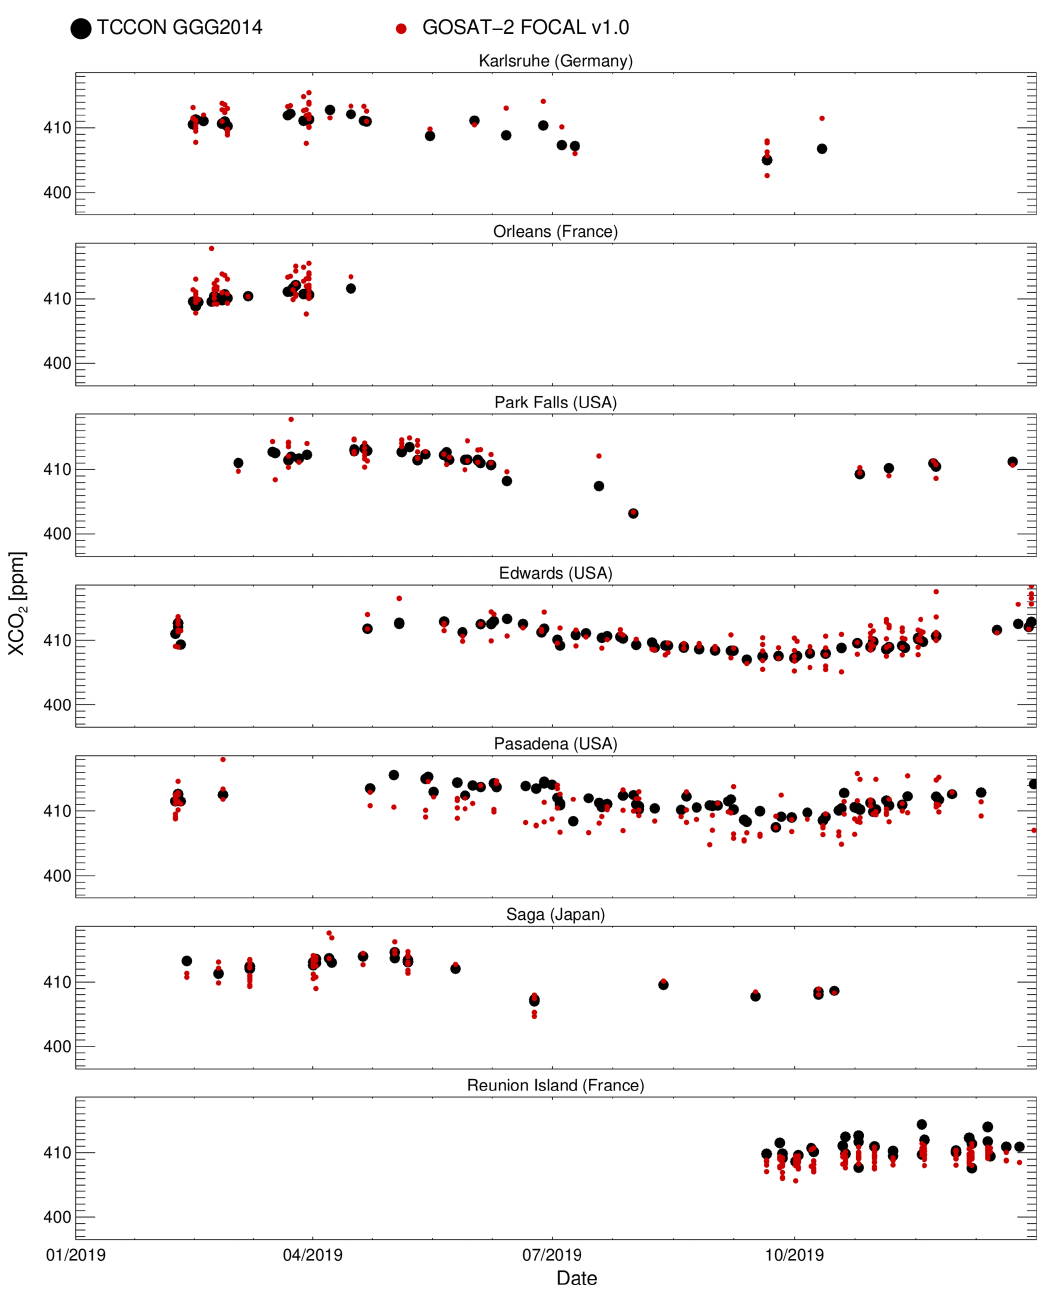
Figure 17. Time series of collocated FOCAL GOSAT-2 data at various TCCON